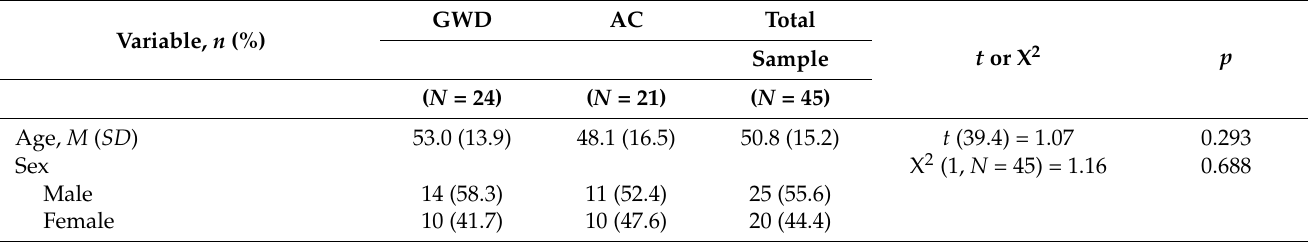
Table 1. Demographic and clinical variables according to treatment condition at baseline.